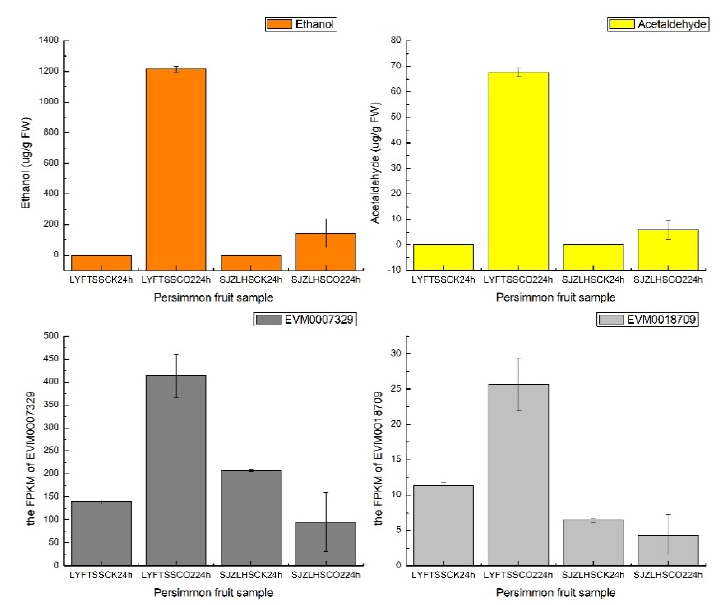
Figure 8. The ethanol production ( µ g/g FW) and acetaldehyde production ( µ g/g FW) of four per- simmon fruit groups, along with the FPKM value of the two newly detected genes ( EVM0007329 and EVM0018709 ) detected by C-CorA.